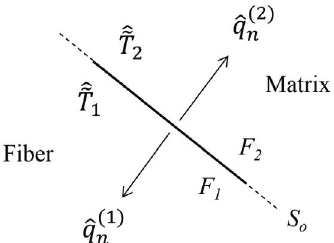
Figure 4. Interface